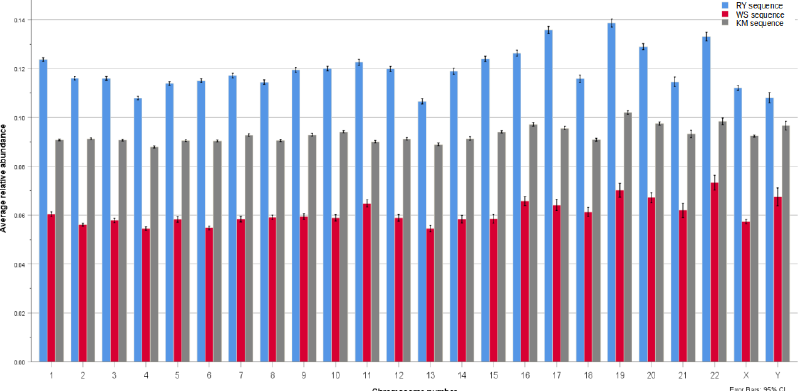
Figure 3. Binary components’ distance from randomness. The dinucleotide relative abundance— distance from randomness values show that each of the RY, WS, and KM binary components have very distinct profiles within any given human chromosome. A value of zero is synonymous with a randomized sequence or model. Within each of the human chromosomes, the RY binary sequence component is the least random, followed by the KM sequence, and then the WS sequence, which is the closest to randomness. This suggests that RY is the most prominent and important feature in terms of general designs of DNA. Since purines/pyrimidines are structural properties and determinants of DNA secondary structure, this suggests a potential RY structural code that is prevalent in human DNA in general, and across all chromosomes. KM and WS components determine the chemical properties of the bases, including hydrogen-bonding capability (and patterns), and this property is closer to randomness, and therefore, of lesser prominence.